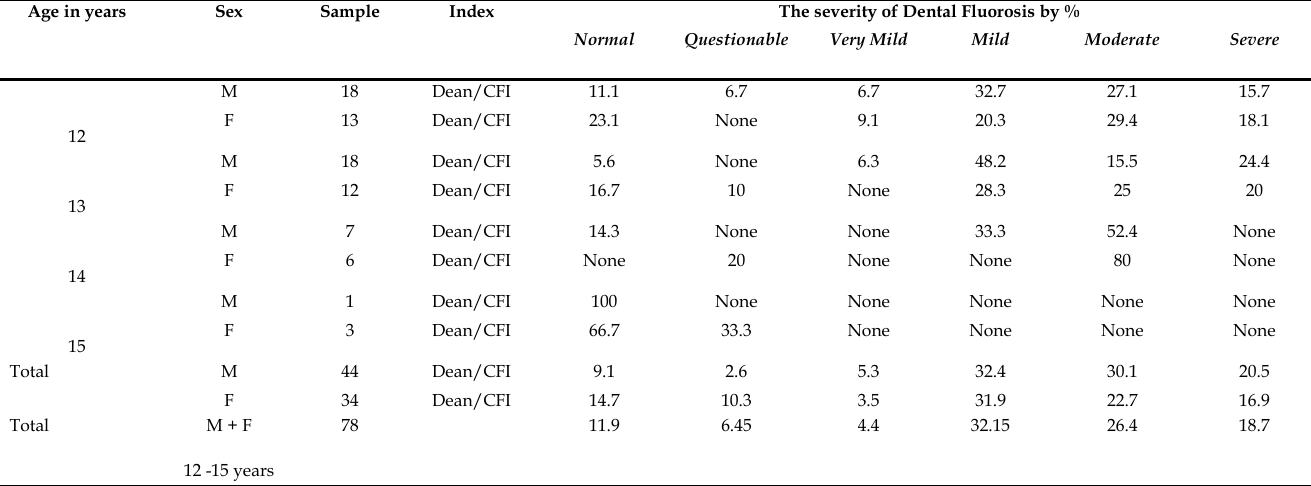
Table 4: The severity of dental fluorosis in the rural studied population Age in years Sex Sample Index The severity of Dental Fluorosis by %